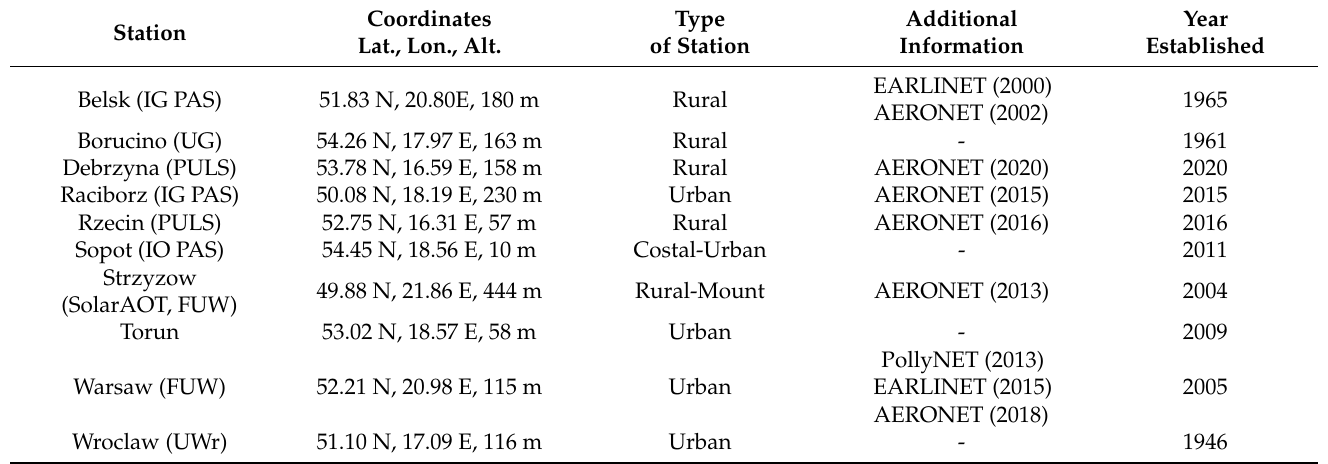
Table 1. Basic information about the Poland-AOD aerosol research network stations. Coordinates Station Lat., Lon., Alt.